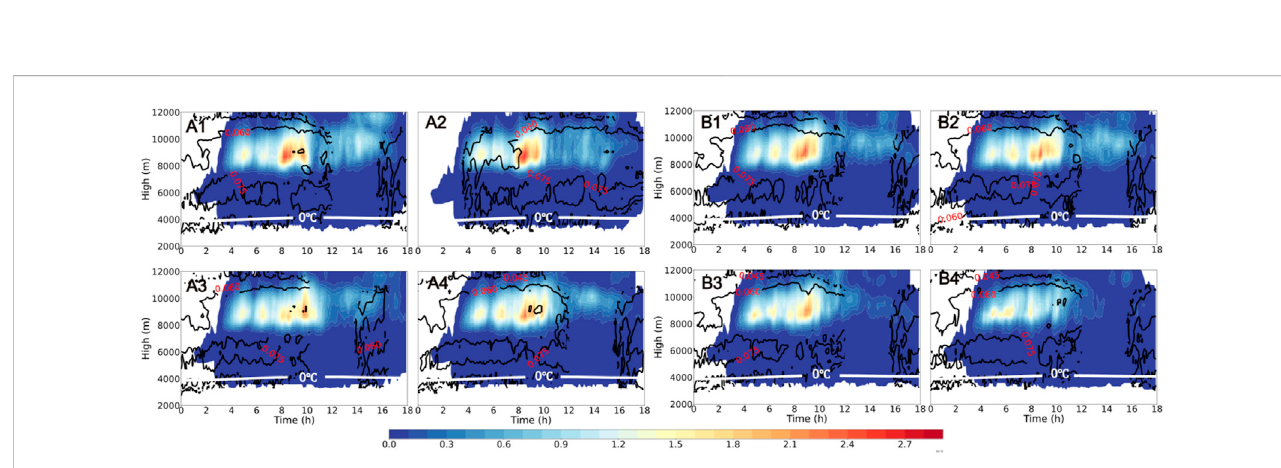
FIGURE 13 Timevariationoftheheightdistributionoficeparticlemixingratio(Unit:10 – 6 g kg − 1 )withthecontourofthemass-weightedaveragediameter(Unit:mm), and the solid white line is the height of 0 ° C (A) TH-AU. (B) MY-AU; (1) NCCN50 (2) NCCN200 (3) NCCN 2000 (4)